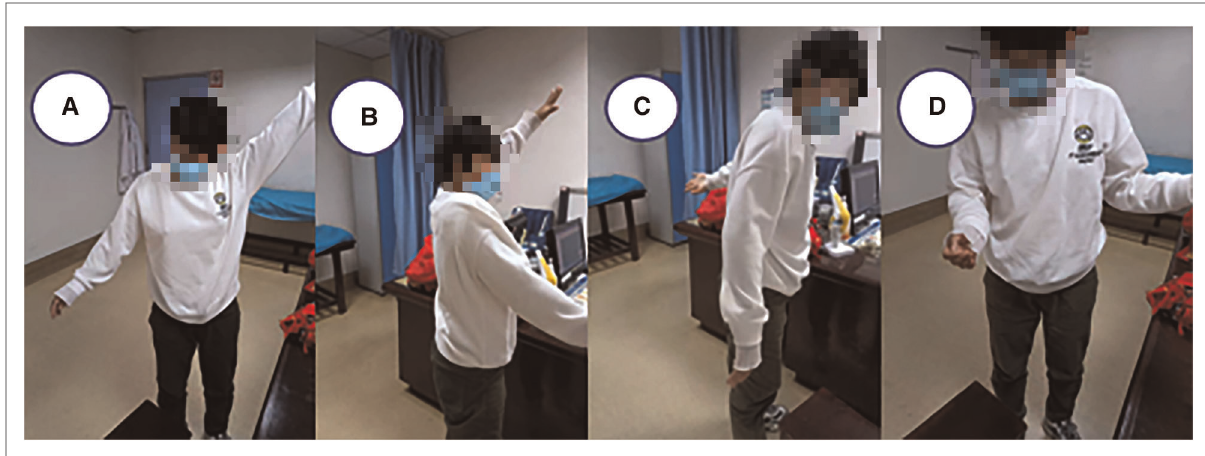
FIGURE 2 Preoperative physical examination for shoulder joint mobility in all